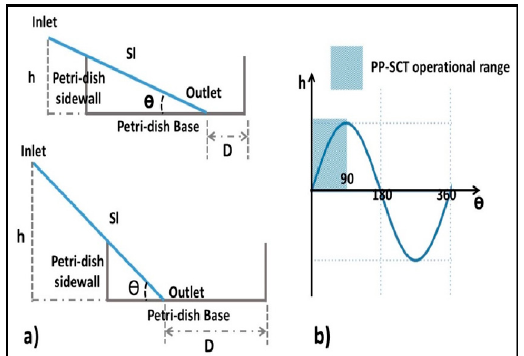
Figure 3. ( a ) Shows the varying operational position using the PP-SCT technique; ( b ) shows the